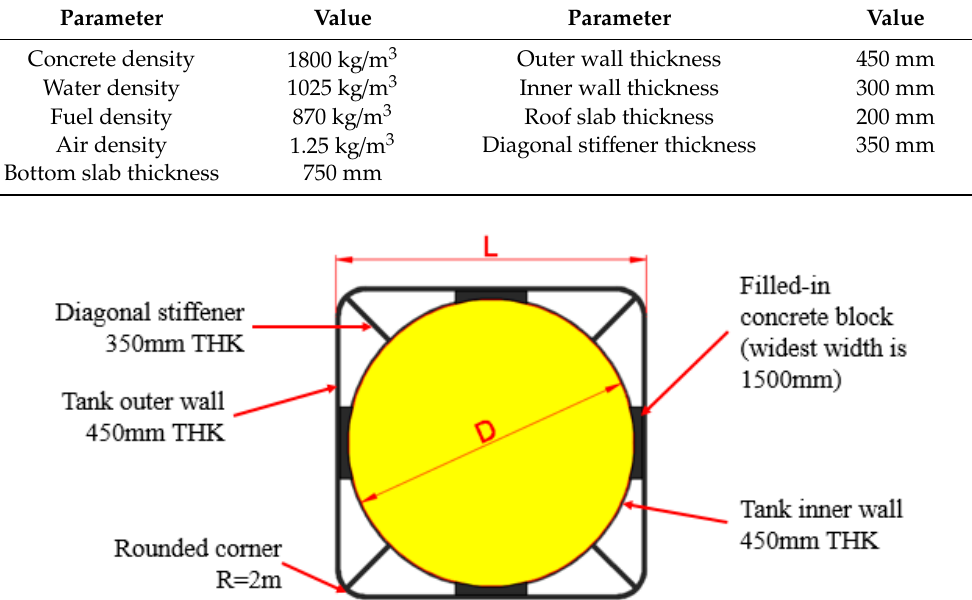
Figure 14. Initial design of floating storage tank (planar cross-sectional view).